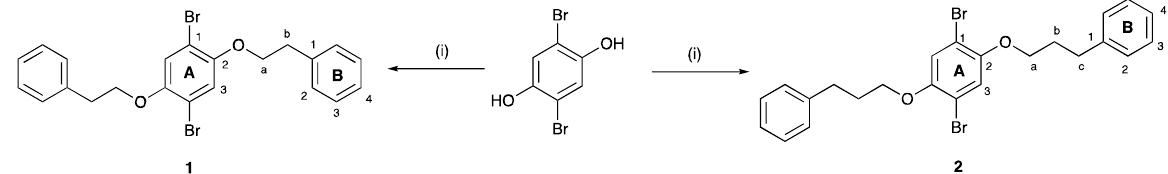
Scheme 3. Synthetic route to compounds 1 and 2 . Reaction conditions: (i) (2-bromoethyl)benzene or (3-bromopropyl) benzene, anhydrous K 2 CO 3 , DMF, 100 ◦ C, 22 h. Yields: 1 , 71.7% and 2 , 87.3%. The ring and atom labelling for the NMR spectroscopic assignments are